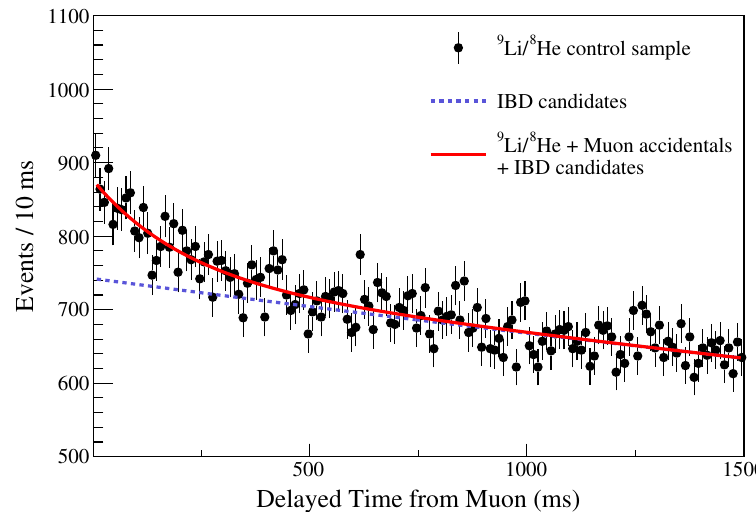
Figure 11 . Delayed time distribution of IBD-like pairs from their preceding energetic muons in the near detector. There are three components of muon-induced accidental background, 9 Li/ 8 He background, and IBD signal. The 9 Li/ 8 He background is clearly seen within 500 ms after an energetic